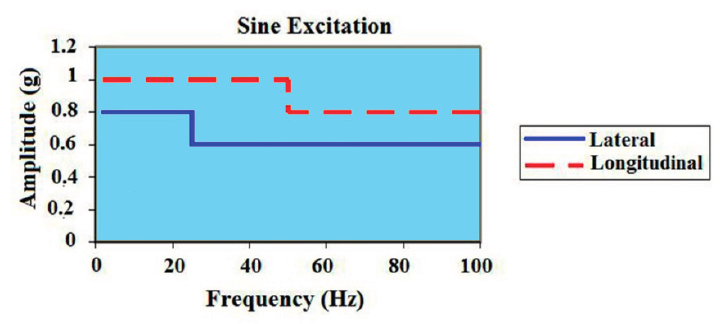
Figure 12. Arian 5 sinusoidal vibration, adapted from